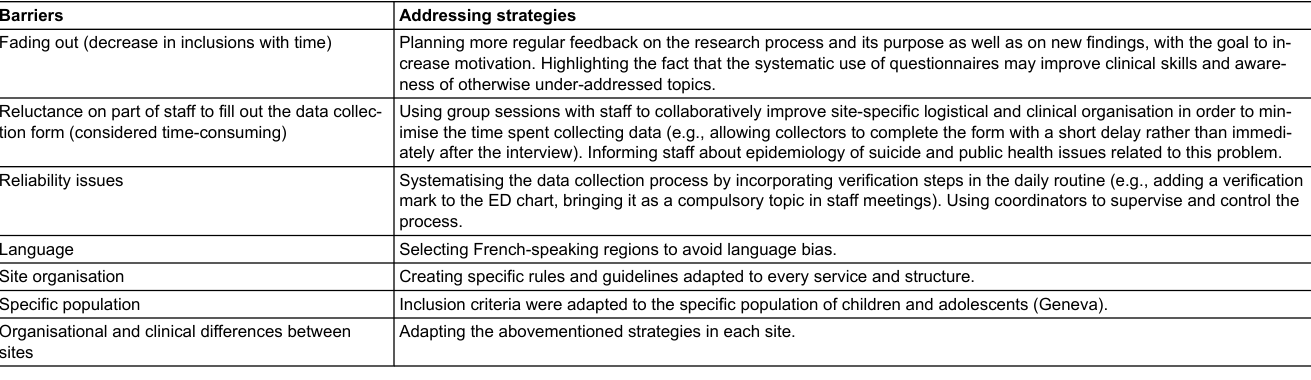
Table 3: Overall and gender-specific self-harm rates by site *